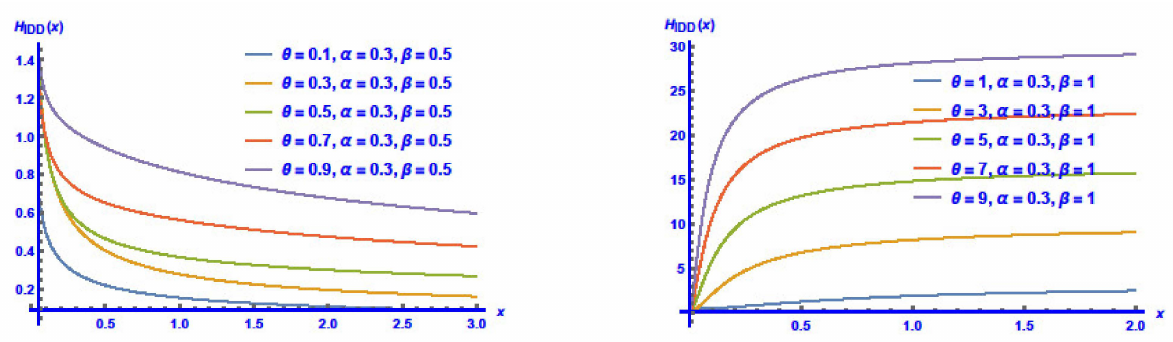
Figure 5. The hazard function plots of the PDD for some values of parameters.